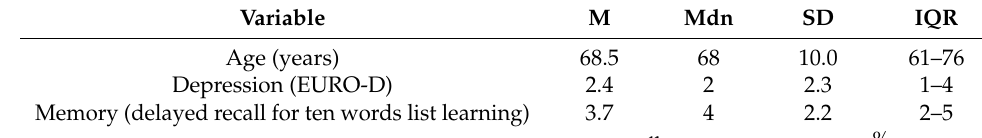
Table 1. Summary of cohort